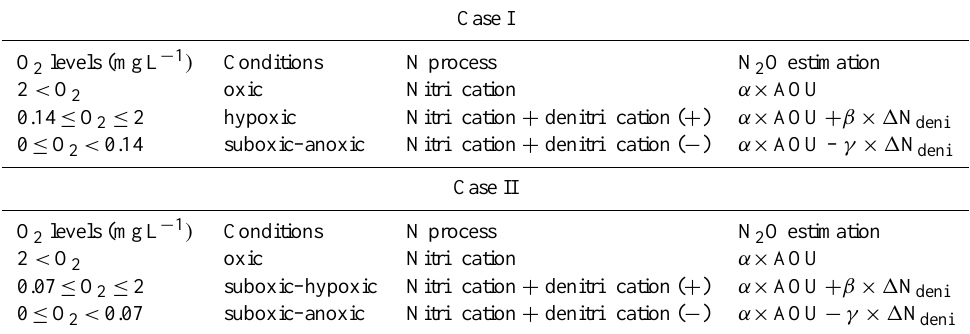
Table 1. Summary of O 2 criteria determining nitrogen (N) processes affecting N 2 O production and consumption according to Cases I and II. Case II is given to examine the sensitivity on the threshold O 2 values for N 2 O production/consumption by